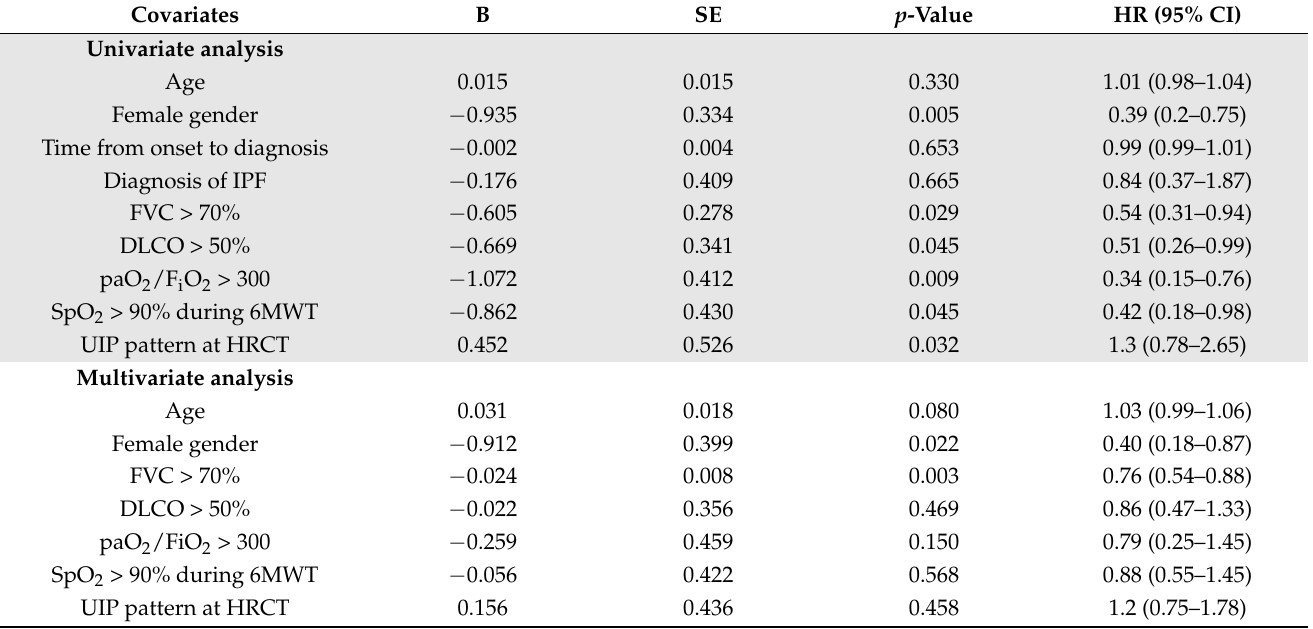
Figure 2. Cox regression analysis for survival of study population, stratified according to gender (on the left ; Male: red line) and basal FVC% of predicted value (on the right ; FVC < 70% of predicted value: red line). The covariates are reported in Table 2. Table 2. Univariate and multivariate analysis for mortality in the entire study